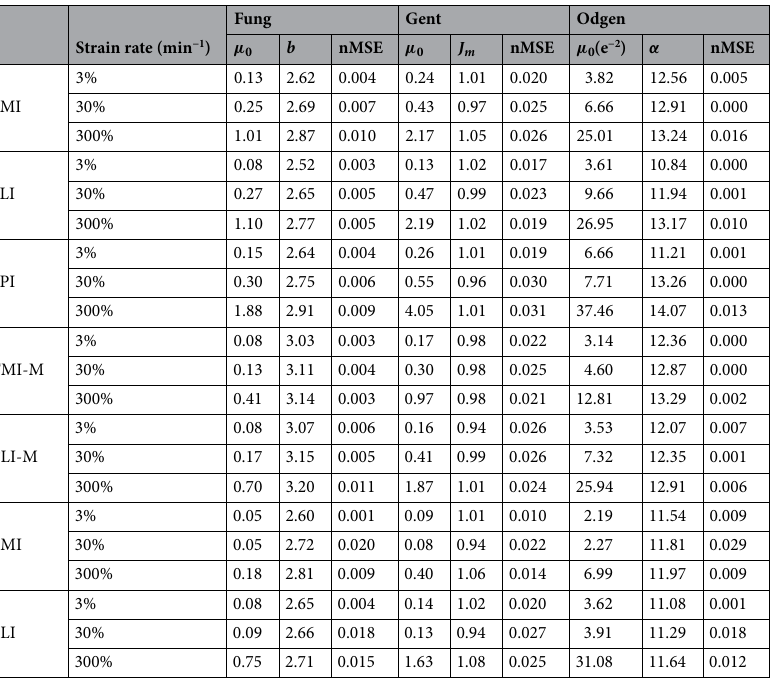
Table 2. Material parameters for cartilage obtained by fitting the models to experimental data. *The unit of µ 0 is